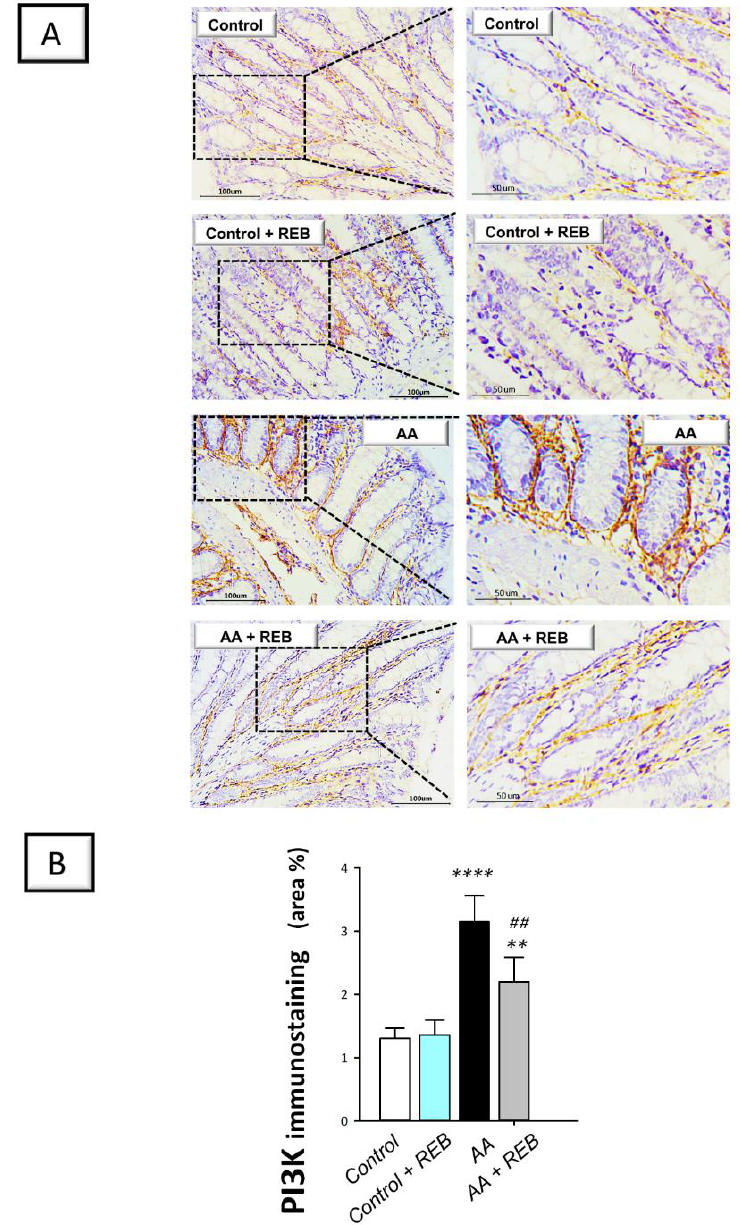
Figure 5. Rebamipide inhibits the colonic PI3K/AKT pathway in rats exposed to acetic acid-induced colitis. ( A ) Immunostaining of the phosphoinositide-3 kinase (PI3K) pro-inflammatory signal in the colonic tissue. ( B ) Quantification of the colonic PI3K immunostaining. Each bar represents the mean ± S.D. ( n = 6). A one-way ANOVA statistical test was conducted to analyze the significant difference among tested groups followed by a Tukey’s test. ** p < 0.01, or **** p < 0.0001, significant from the control group. ## p < 0.01, significant from the colonic injury group. REB, rebamipide; AA, acetic acid.